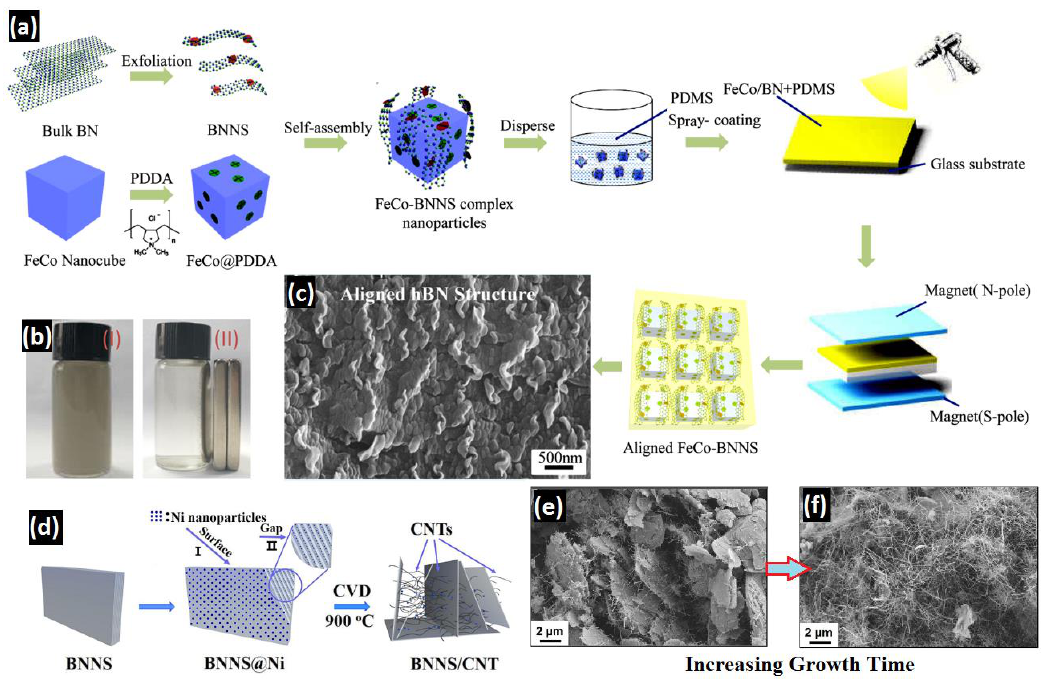
Figure 6. ( a ) Self-assembly and magnetic-assisted techniques in synthesizing vertically aligned BNNSs / PDMS composite, ( b ) response of FeCo-BNNSs complex to external magnetic field, ( c ) SEM image of vertically aligned BNNSs vi the help of magnetic FeCo nanocubes (Reprinted with permission from the American Chemical Society, Copyrights 2019) [62]. ( d ) In-situ growth of CNTs on the surface of BNNSs by CVD rout, ( e , f ) SEM images of CNT / BNNSs hybrid filler under increasing growth time (Reprinted with permission from Elsevier, Copyrights 2019) [68].